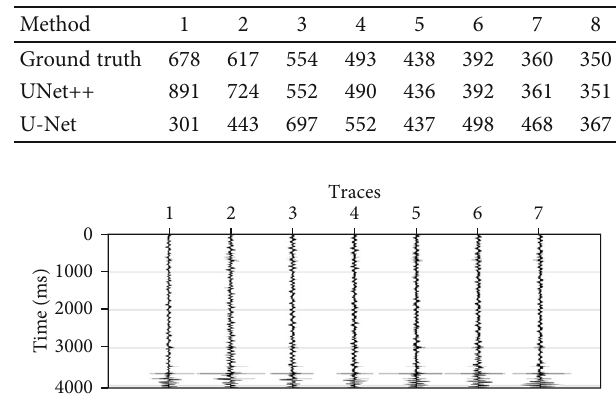
Figure 17: Actual high-SNR microseismic record pro fi le of a working area in Shengli Oil fi